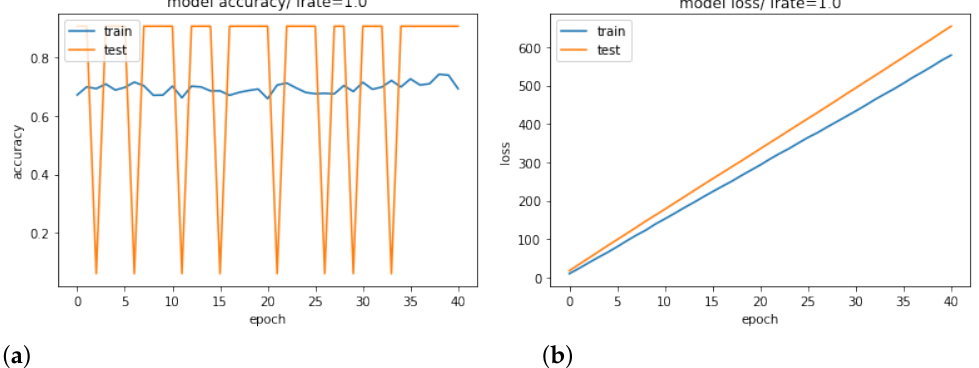
Figure 8. lr = 1. ( a ) Train accuracy: 0.911. ( b ) Test accuracy: 0.908.